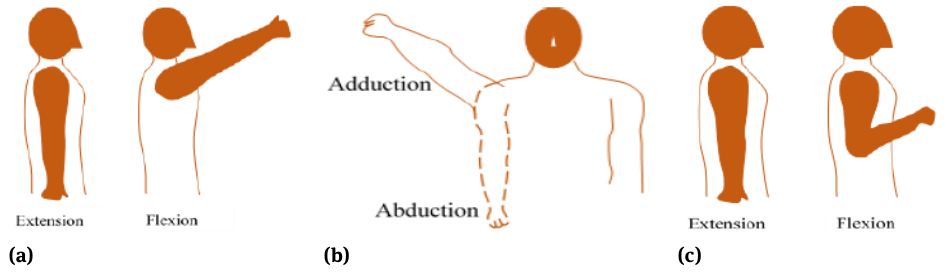
Figure 5: General motion. (a) Shoulder Flexion/Extension (shoulder pitch); (b) Shoulder Abduction/Adduction (shoulder roll) and (c) Elbow Flexion/Extension (elbow